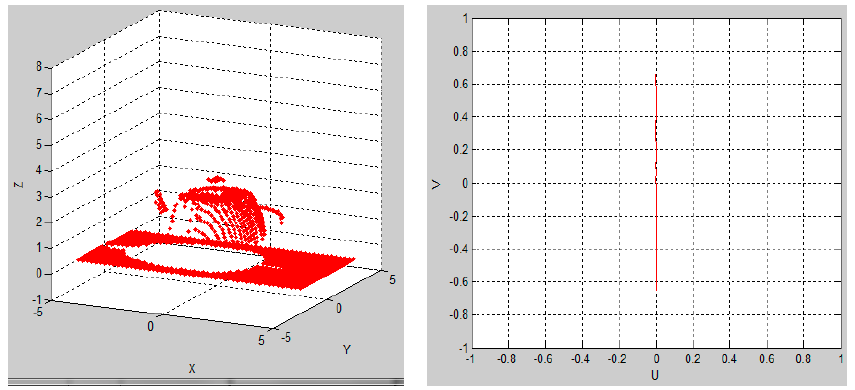
Figure 4. Simulation running when default parameters were used.